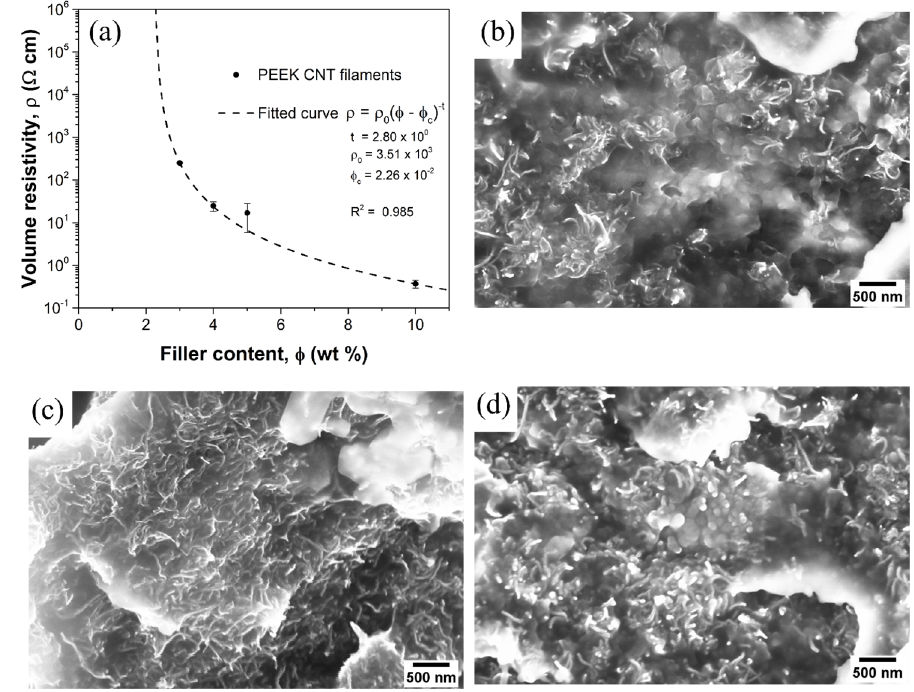
Figure 2. ( a ) Volume resistivity as a function of CNT amount for all filaments; SEM micrographs on tensile tested ( b ) PEEK 3CNT, ( c ) PEEK 5CNT and ( d ) PEEK 10CNT filaments.